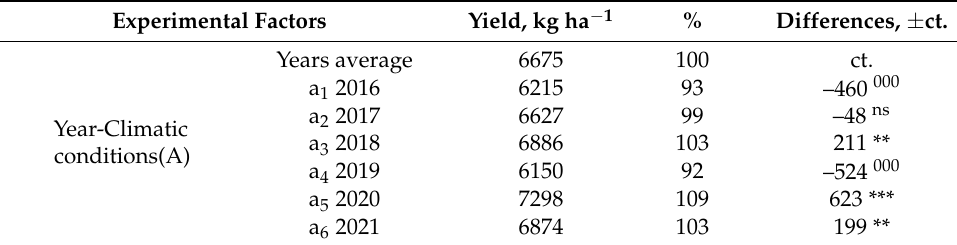
Table 5. Influence of climatic conditions on maize average yield, 2016–2021. Experimental Factors Yield, kg ha − 1 % Differences, ± ct.